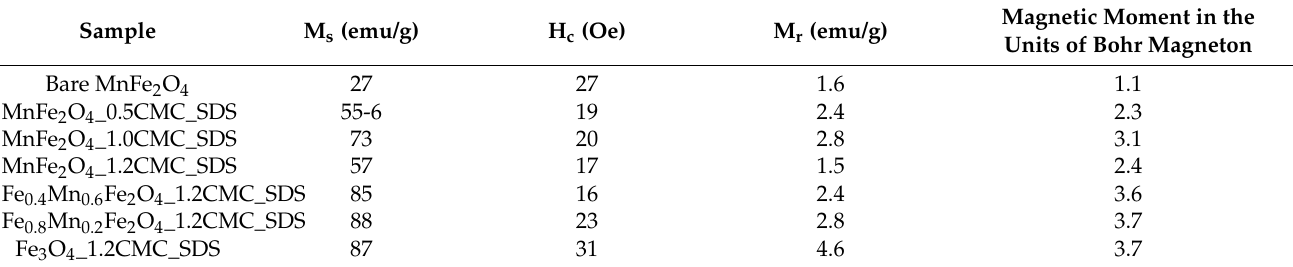
Table 2. The saturation magnetization (M s ), coercivity (H c ), remanent magnetization (M r ), and magnetic moment in the units of Bohr magneton of the synthesized bare MnFe 2 O 4 and MnFe 2 O 4 at various SDS surfactant concentrations,